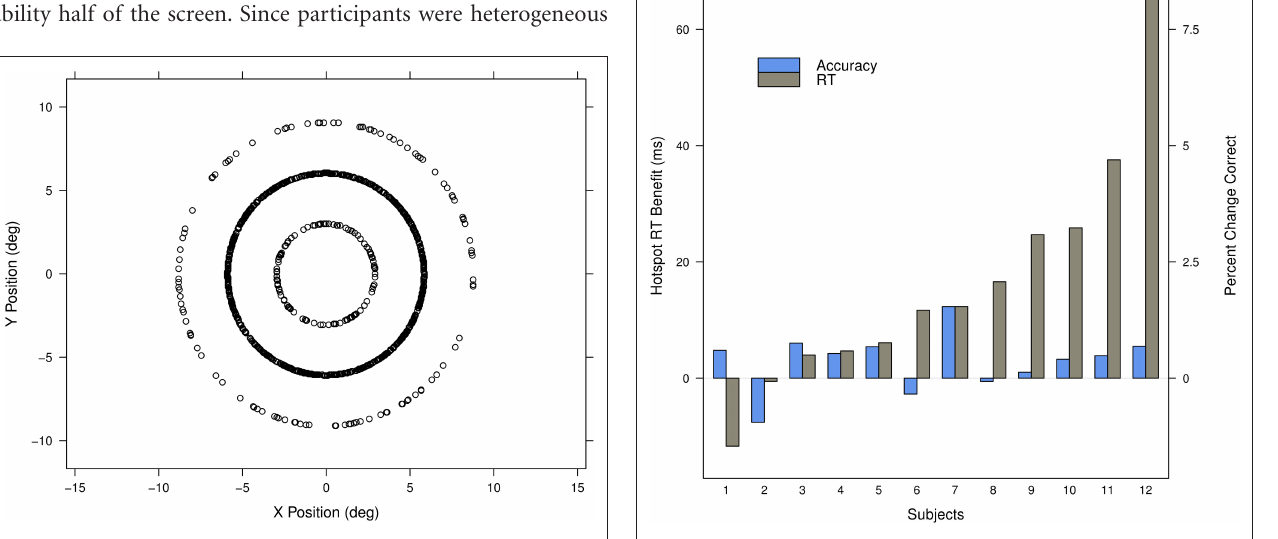
centimeters near fixation subtended just over 4 ° of visual angle.